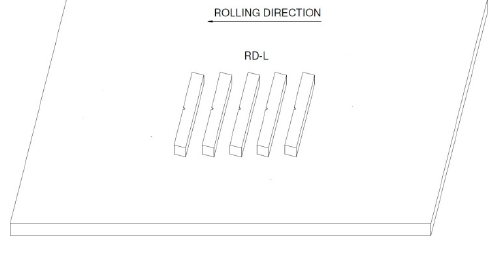
Figure 3. Orientation of CVN samples.